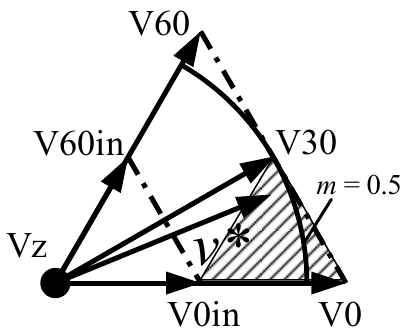
Figure 4. Operation principle of support vector machine (SVM).